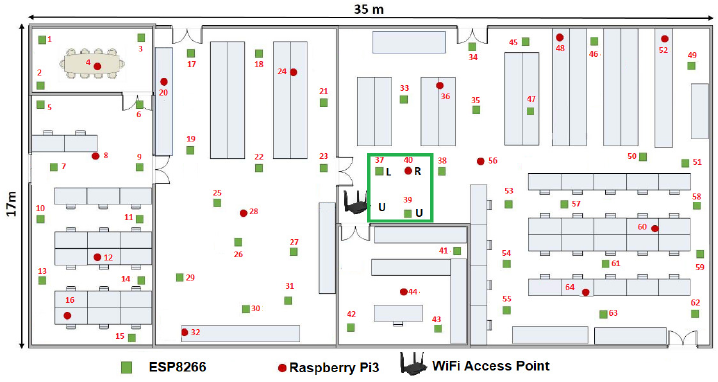
Figure 12. MCU 37 ( t 0 ) as the seed MCU using the axiom U −→ LUUR